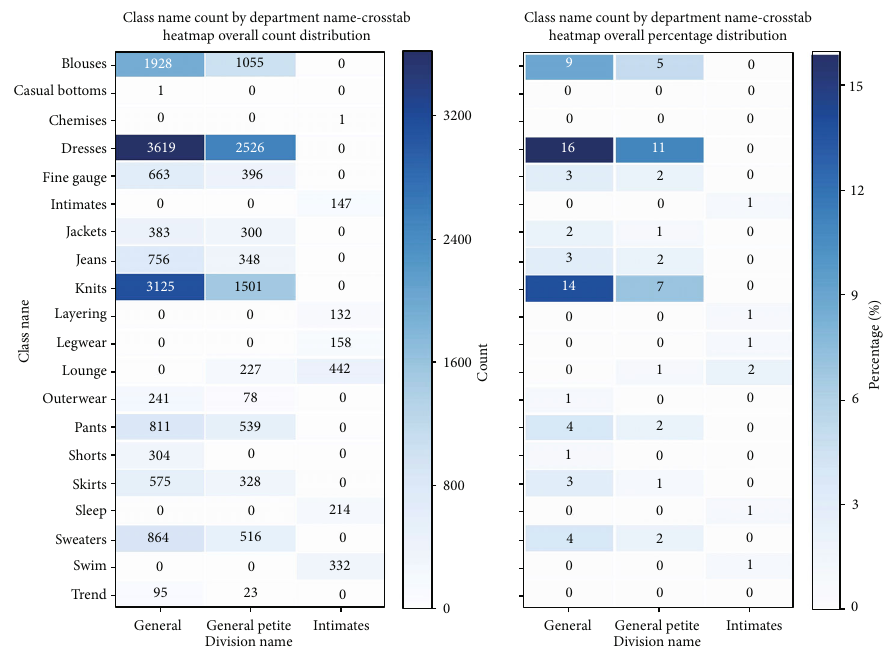
Figure 11: The types of clothing often reviewed, such as skirts, general-sized blouses, and across multiple categories, as seen in Figure 8. There had